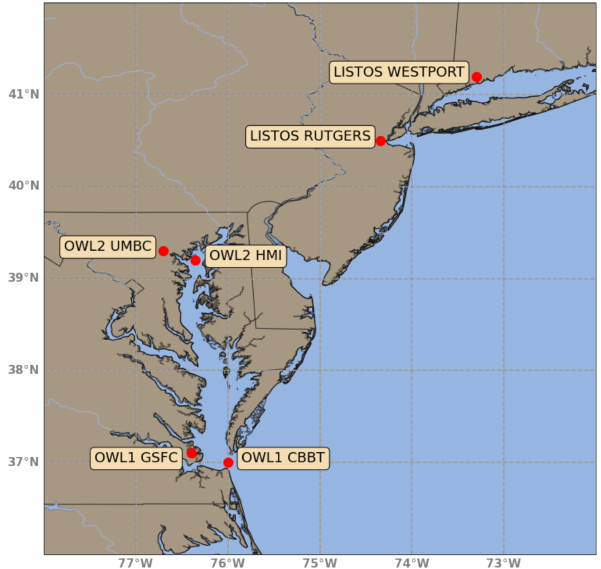
Figure 1. An inset map of the Chesapeake Bay airshed in Mary- land, Virginia, and Long Island Sound in New York with the six lidar monitoring locations used for OWLETS-1, OWLETS-2, and LISTOS highlighted and